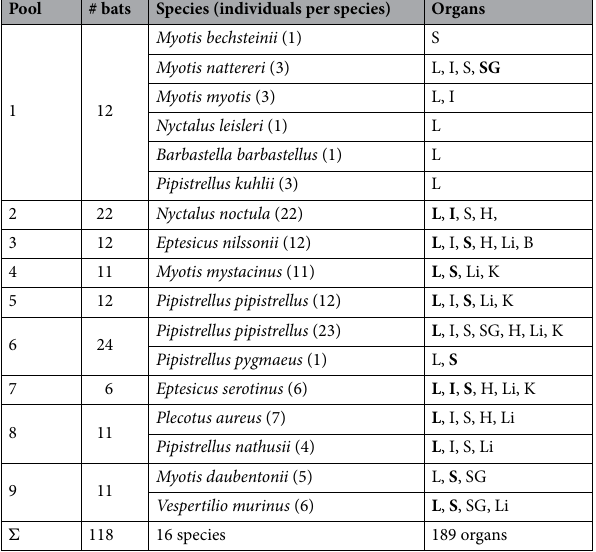
Table 5. Composition of bat pools. Table summarizes species and organs for the nine individual pools used for metagenomics sequencing and cell culture isolation. Organs written in bold have the highest percentage in the individual pool. # number, L lung, I intestine, S spleen, SG salivary gland, H heart, Li liver, K kidney, B